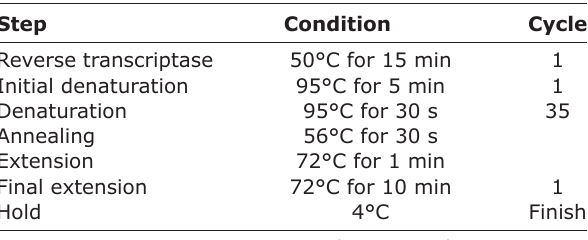
Table-3: Thermocycler conditions of the